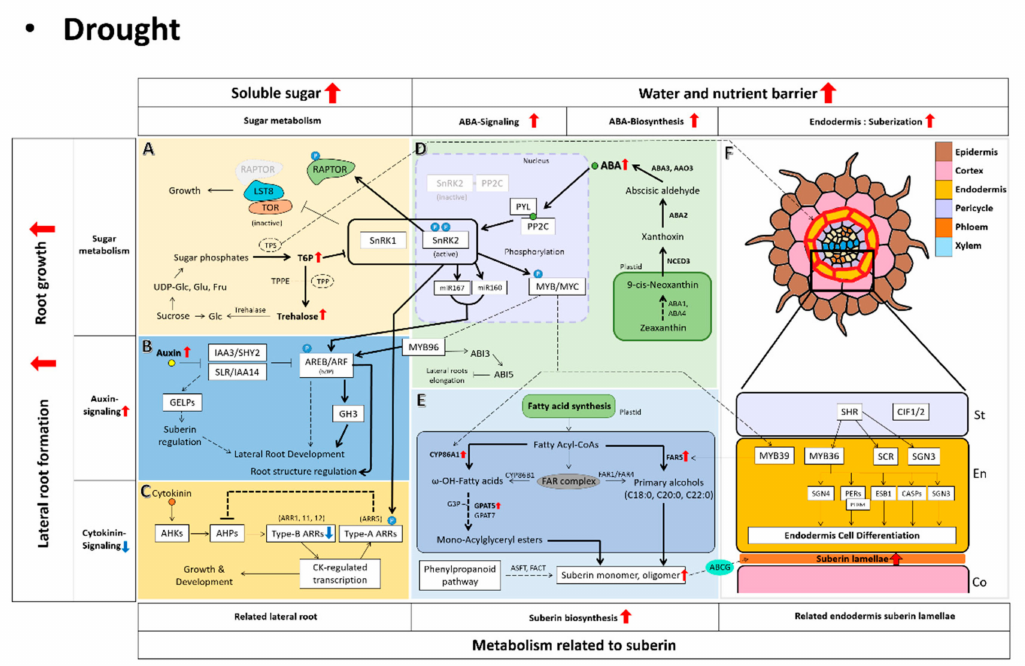
Figure 4. Root signaling model in drought stress. In drought, root-resistant signaling is carried out based on ABA signaling, and trehalose and sucrose sugars are also seen as major indicators of